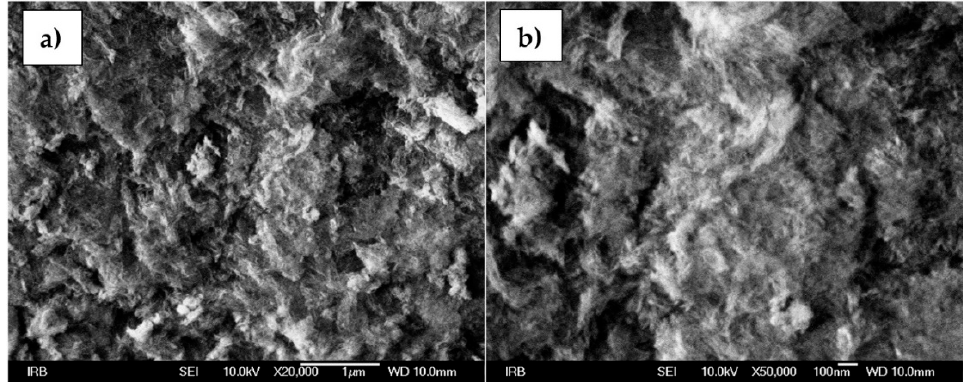
Figure 6. The final observed PXRD profile of alumina NPs at RT. The upper green tick marks show the reflection positions of the hexagonal Al 2 O 3 phase formation.